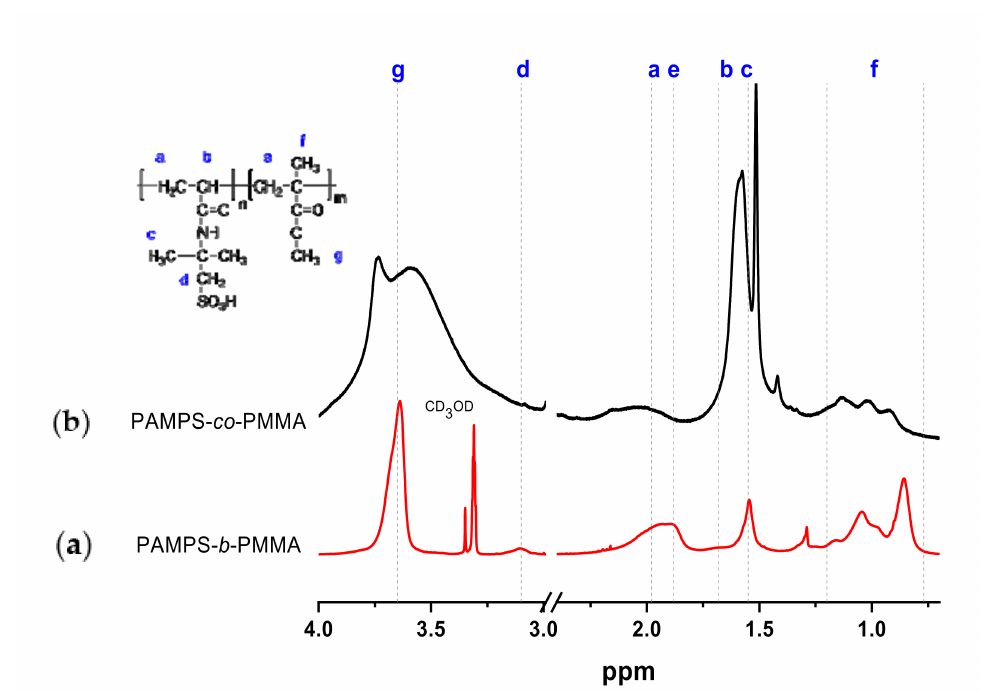
Figure 1. ( a ) 1 H-NMR spectrum of PAMPS- b -PMMA in CD 3 OD and ( b ) PAMPS- co -PMMA in DMF-d 7 . Molar composition [AMPS] o /[MMA] o = 1/2.